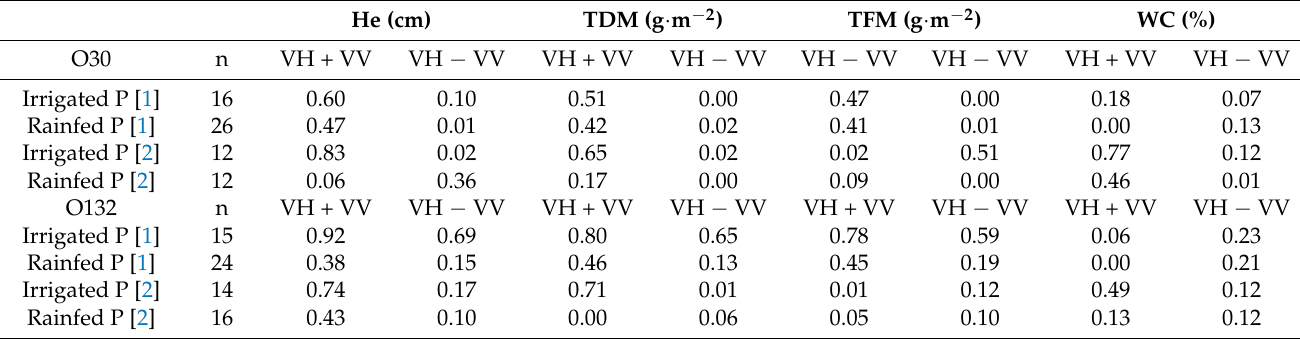
Table 5. Comparison between the statistical coefficients R 2 determined between all crop parameters and VH + VV and VH – VV for the two orbits O30 and O132 respectively.